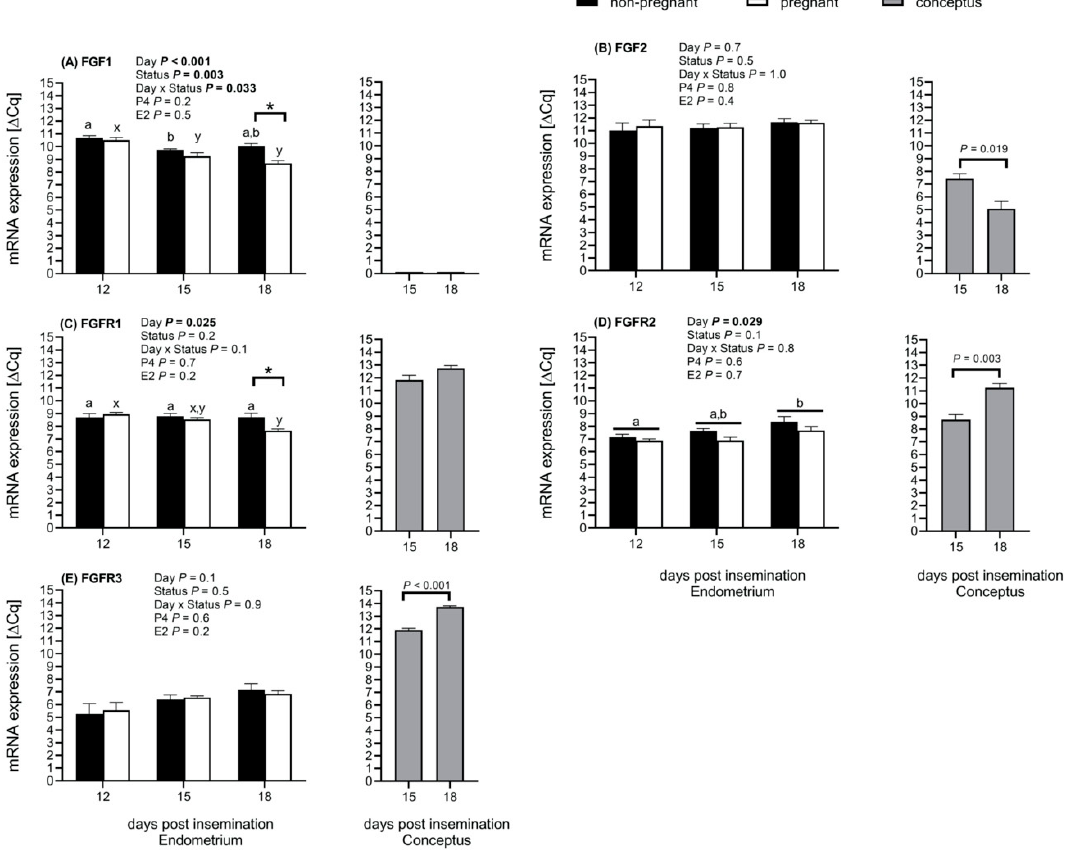
Figure 1. The mRNA was expressed in the endometrium of nonpregnant ( n = 5 to 8) and pregnant ( n = 5 to 6) Simmental heifers at Days 12, 15, and 18 post insemination as well as conceptus at Days 15 ( n = 4 to 8) and 18 ( n = 4) (insemination = Day 0). ( A ) mRNA expression of fibroblast growth factor 1 (FGF1) and the mRNA transcripts’ abundance was below the detection limit on Days 15 and 18 in the conceptuses; ( B ) FGF2 mRNA expression; ( C – E ) mRNA expression of FGF receptors 1 (FGFR1), FGFR2, and FGFR3 (IIIc isoforms). An asterisk (*) indicates significant di ff erences between groups and di ff erent letters within nonpregnant (a,b) and pregnant (x,y) heifers indicate significant di ff erences within groups over time (days) ( A , B ) and between days ( D ). Abbreviation P4 = progesterone and E2 = estradiol-17 β . The results presented as mean delta quantitative cycle ( ∆ Cq) ± standard error of the mean, and high ∆ Cq represent a high transcript abundance. Di ff erences were considered significant at a 95% confidence interval.